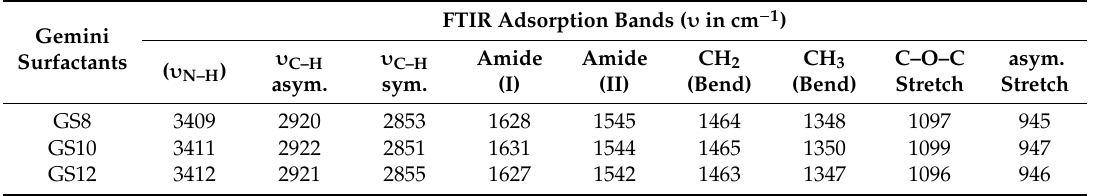
Table 3. FT-IR spectral data of the quaternary ammonium gemini surfactants (GS12). Gemini